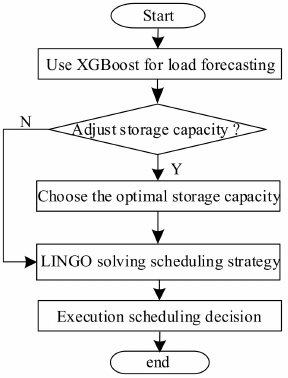
Figure 7. Research